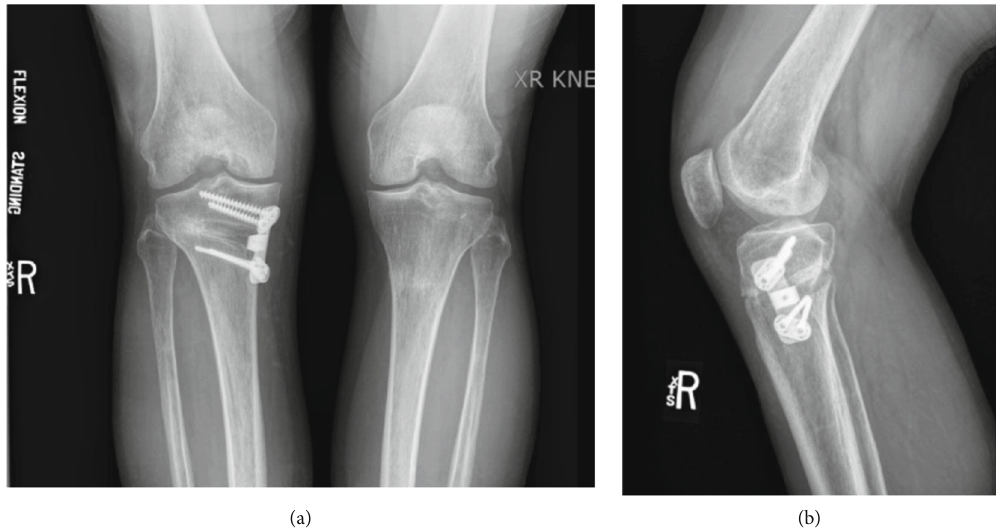
Figure 11: (a) 3-month post-operative posterior-anterior (PA) weight-bearing (WB) view. (b) 3-month post-operative lateral view.